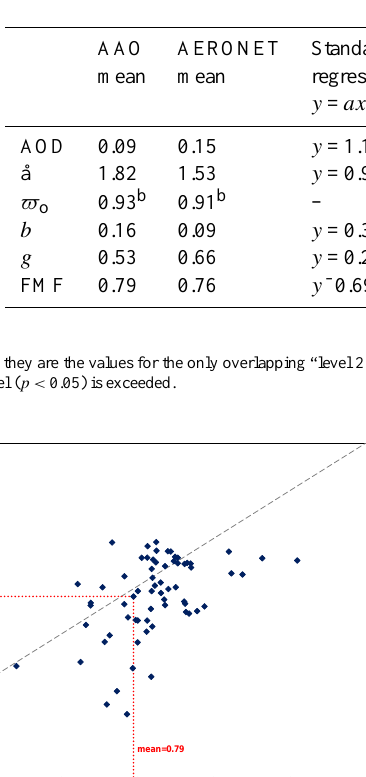
Table 1. Mean values of the AOD, ˚Angstr¨om exponent, single scattering albedo, hemispheric backscatter fraction, asymmetry parameter, and FMF for AAO and AERONET, along with results of least-squares linear regressions and correlation coefficients for the comparison between AERONET and AAO.